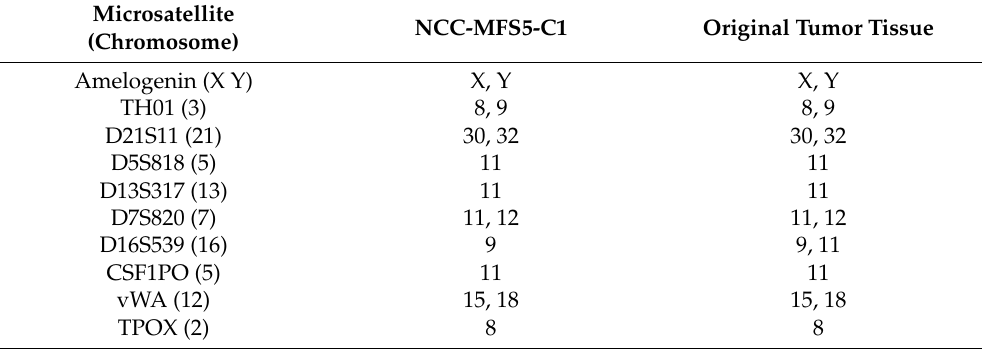
Table 1. Short tandem repeat